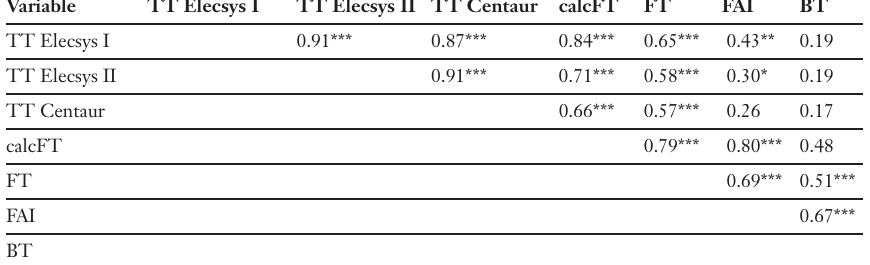
Correlation coeffi- cients (R) between different testosterone levels.